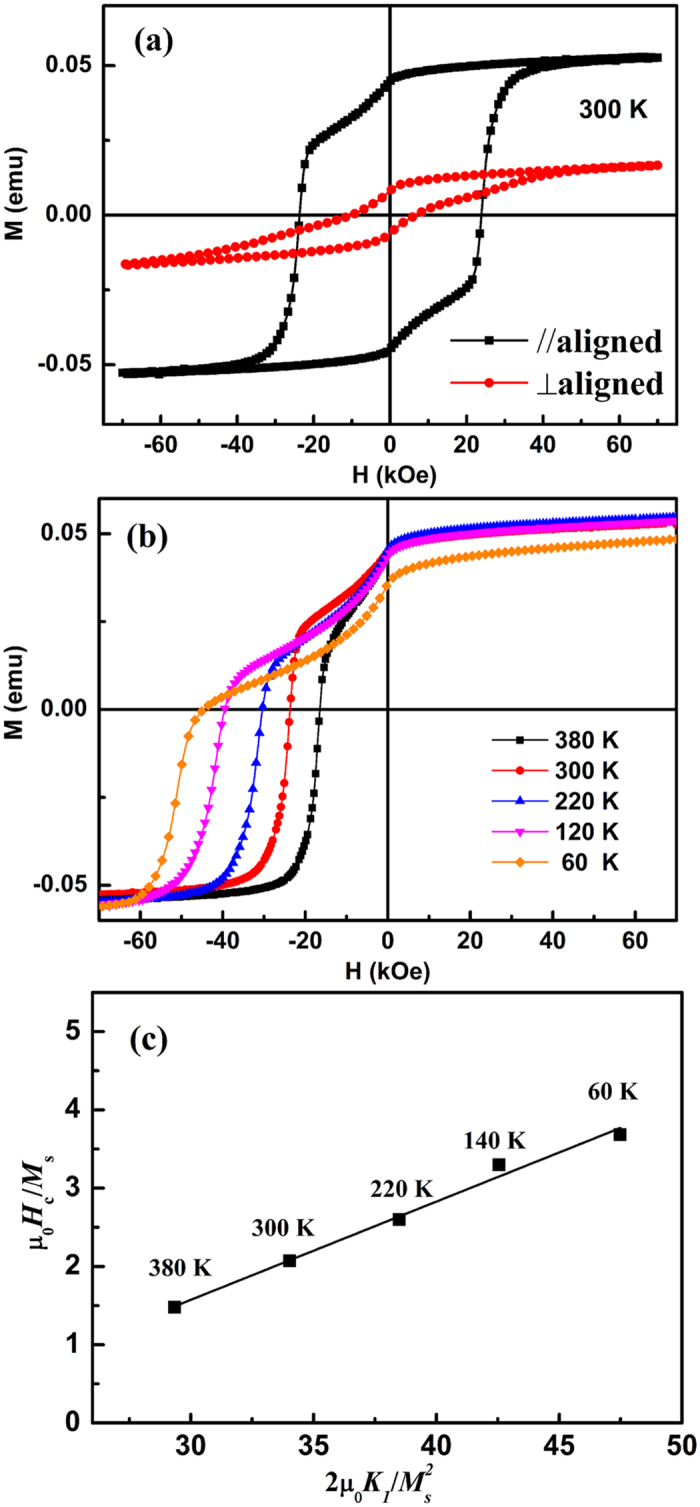
(a) The hysteresis loop, (b) temperature dependence of demagnetization curves and (c) μ0Hc/Ms against on different temperature for aligned SmCo5 nanoflakes resin composite.